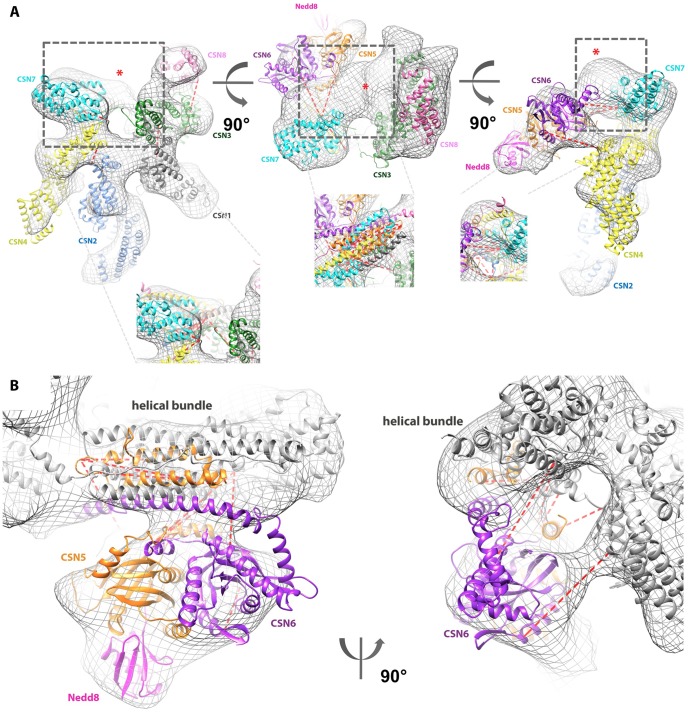
The CSN topology.Inter-subunit cross-links between CSN5 or CSN6 Lys and other CSN subunits (Cα distances <40 Å) are marked with red dotted lines. (A) The CSN assembly revisited, displayed in the EM density obtained by [8] (grey mesh). A red star indicates an unoccupied electron density region. Close-up views of this region are shown after fitting of the helical bundle. (B) CSN5-Nedd8/CSN6 complex positioned in the EM envelope. CSN5 is shown in orange, CSN6 in purple and Nedd8 in magenta. CSN subunits (other than CSN5 and CSN6) are shown in white for context.